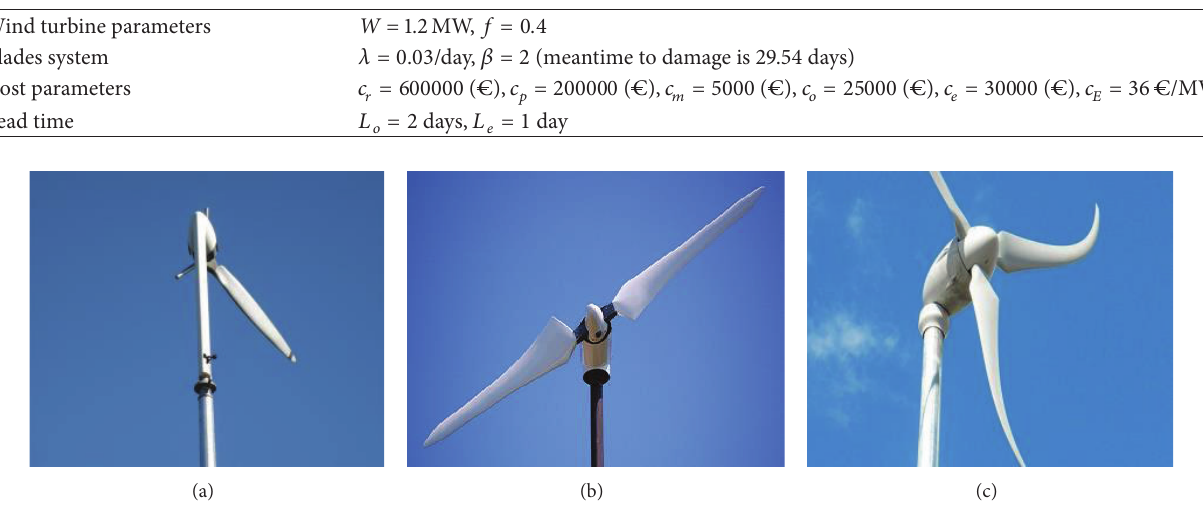
Table 1: Summary of the parameter values.